Question: What form of chart is displayed?
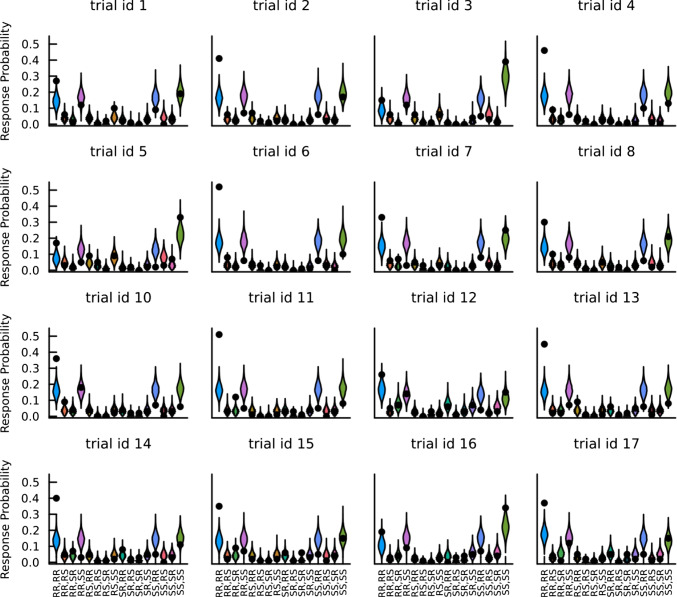
Answer: box